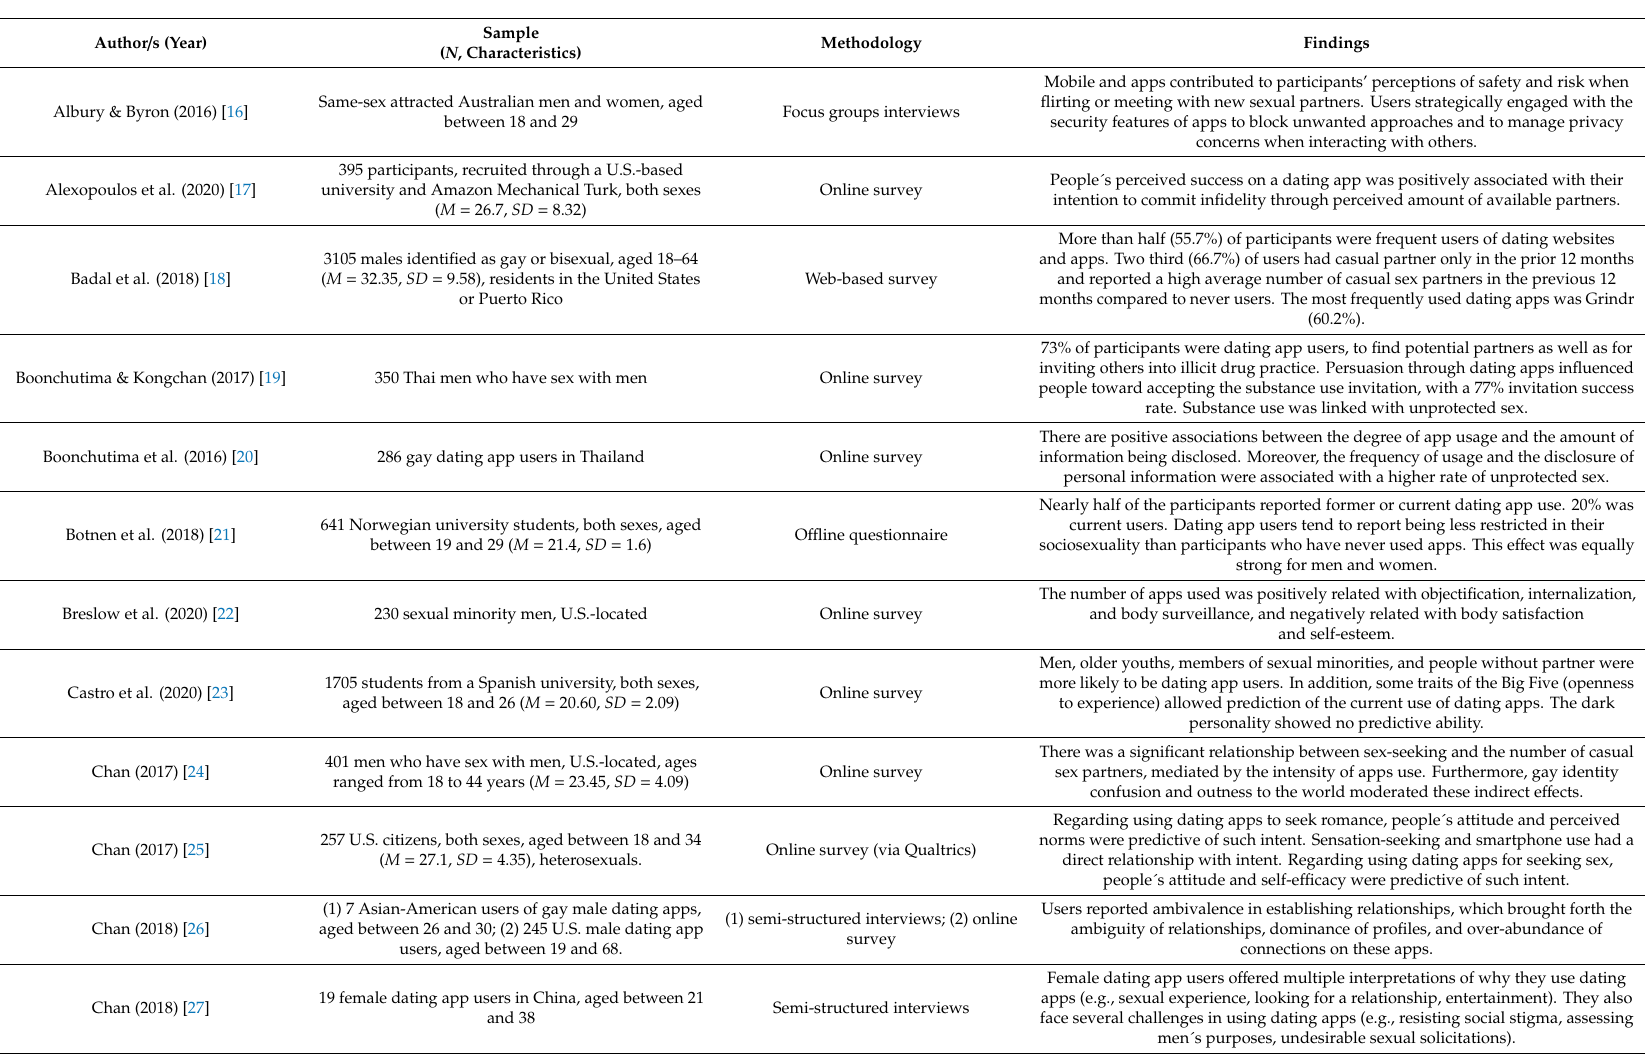
Table 1. Characteristics of reviewed